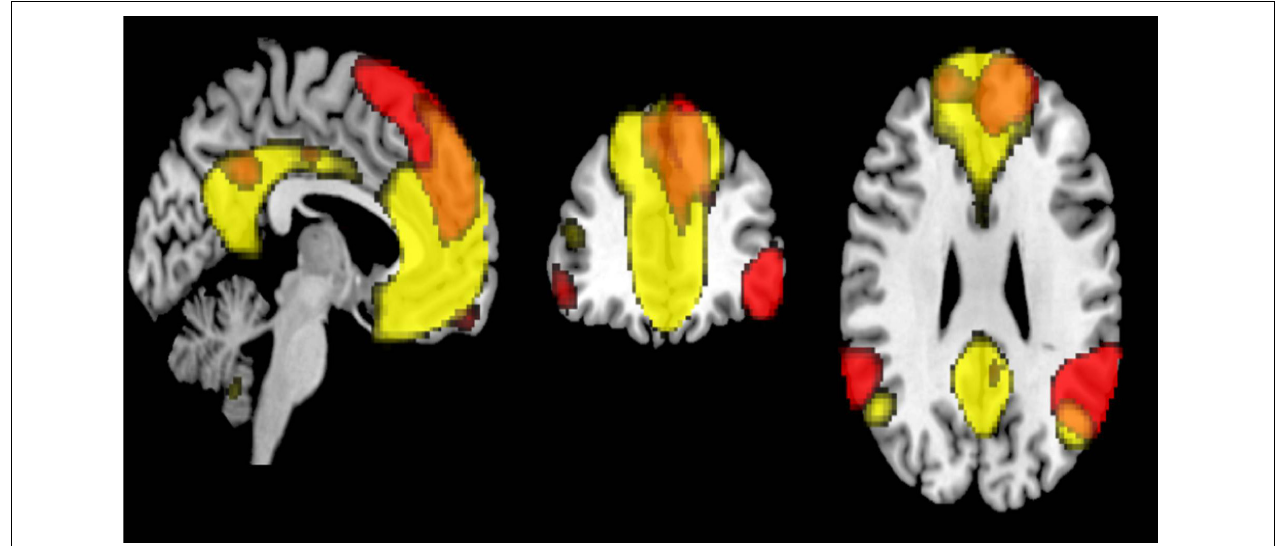
FIGURE 7 | The overlapped regions between the dorsal default mode network (DMN) and the language network (FWE p <